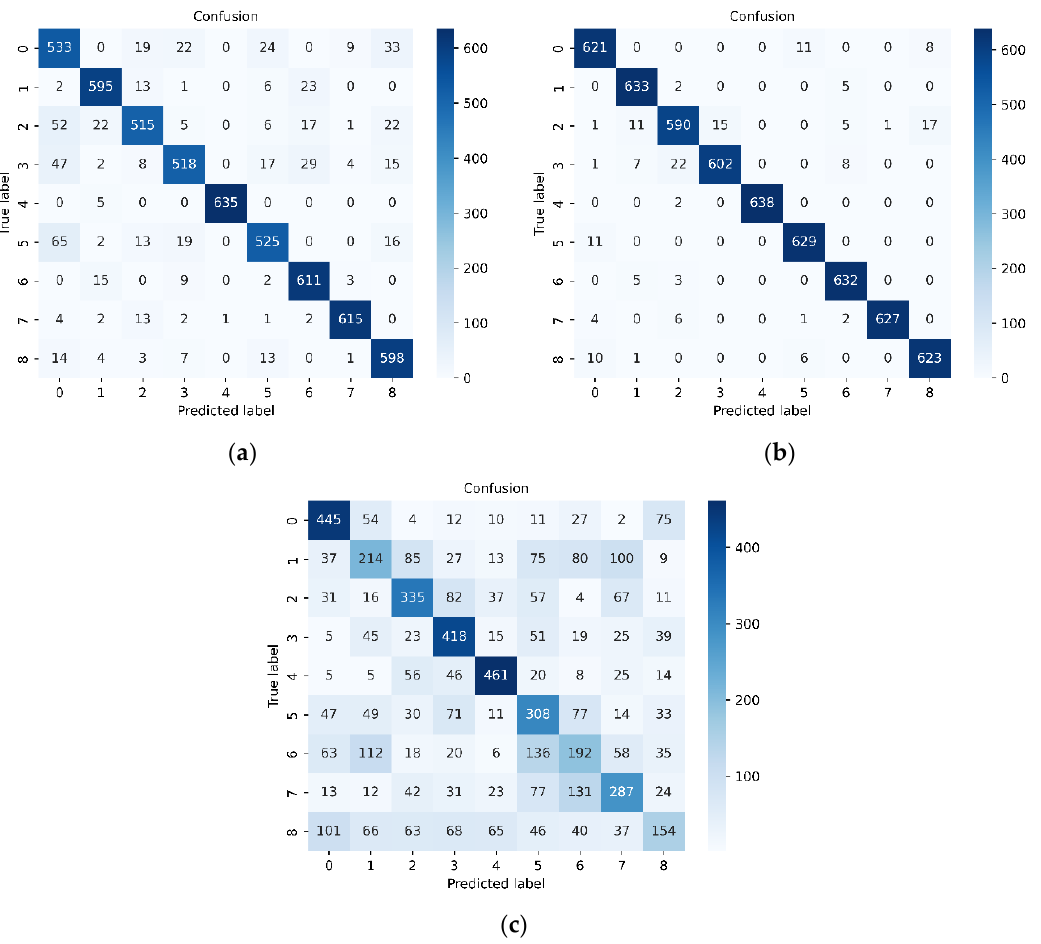
Figure 8. Visualization of local recognition results. 6.2. Contrast Experiments In this section, the proposed method is compared with the methods in the literature [11,12,34,35]. These methods are reproduced to identify ship targets in the AIS dataset used in this paper. The weighted recall, weighted precision, and weighted F1-score are selected as the evaluation indicators. The recall, precision, and F1-score are indicators used to evaluate binary classification. By assigning weights to their values, multiple clas- sifications can be evaluated. The weight is the proportion of the number of each category. The experimental results in Table 1 show that the recognition ability of the proposed method exceeds that of the existing methods. They identify ship targets only using the trajectory information. The Bayesian transformer neural network (BTNN) method pro- posed in a study [35] performs well in target recognition. However, when the number of samples in the dataset decreases, the recognition ability of the BTNN decreases, which is a common problem for deep learning. In this study [35], there were 212,508 trajectories in the dataset, while 28,800 were used in this research. By enhancing the trajectory infor- mation with the context knowledge, the proposed method outperformed other methods. This further proves the effectiveness of trajectory information enhancement and the effec- tiveness of the feature fusion network. The method of context enhancement also provides a solution to overcome the problem of deep learning capability degradation caused by the